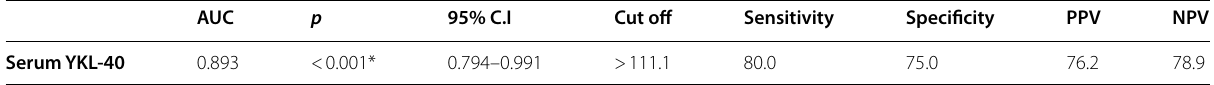
20) from group I ( n 20) = = 20) from group II ( n =